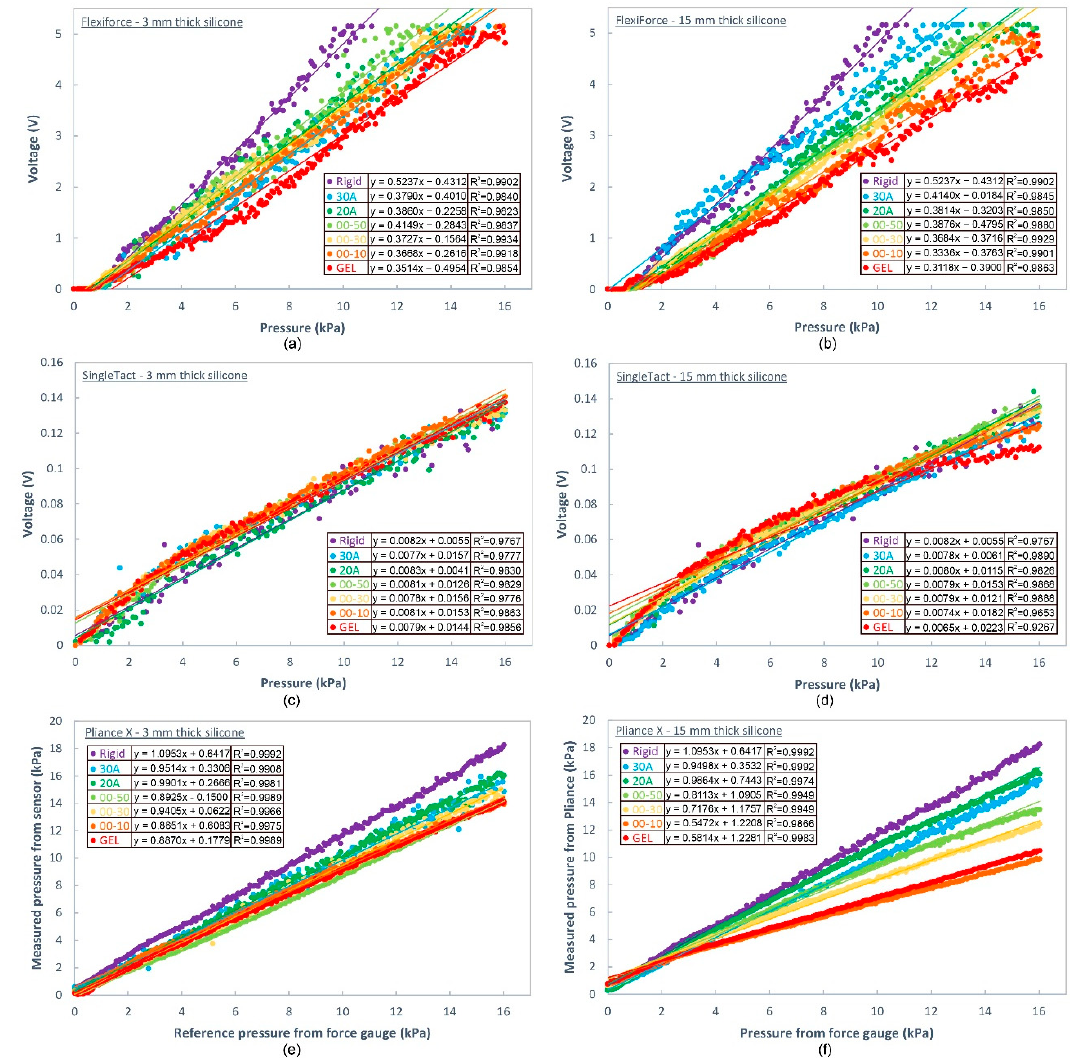
Figure 9. ( a ) FlexiForce sensor calibration curves on rigid and soft (silicone with thickness of 3 mm) surfaces, ( b ) FlexiForce sensor calibration curves on rigid and soft (silicone with thickness of 15 mm) surfaces, ( c ) SingleTact sensor calibration curves on rigid and soft (silicone with thickness of 3 mm) surfaces, ( d ) SingleTact sensor calibration curves on rigid and soft (silicone with thickness of 15 mm) surfaces, ( e ) Pliance X sensor calibration curves on rigid and soft (silicone with thickness of 3 mm) surfaces, and ( f ) Pliance X sensor calibration curves on rigid and soft (silicone with thickness of 15 mm)